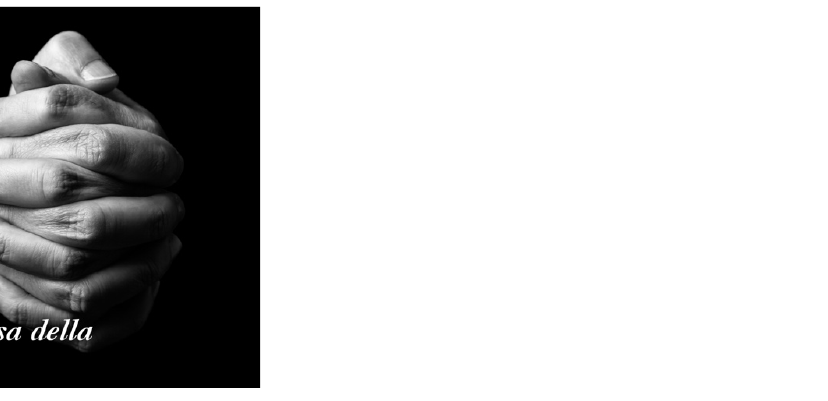
Figure 8. Caterina’s choice of photograph and title: “Promise of loyalty”. Reproduced with permission from www.istockphoto.com (accessed on 29 September 2021).